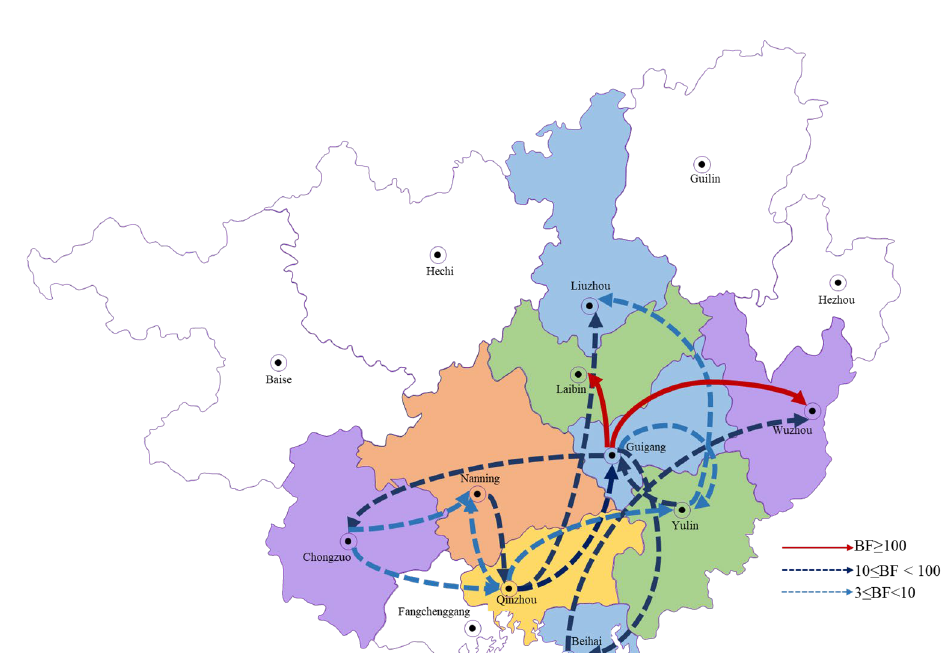
Figure 4. The dynamic analysis of the geographical regions of the partial S1 genes from Guangxi. The curve for all S1 partial genes in Guangxi shows the among-city virus lineage transitions statistically supported with a Bayes factor > 3. The solid red line represents BF ≥ 100 (indicated very strong support), the dark blue dotted line represents 10 ≤ BF < 100 (indicated strong support) and the light blue dotted line represents 3 ≤ BF < 10 (indicated statistically significant support).